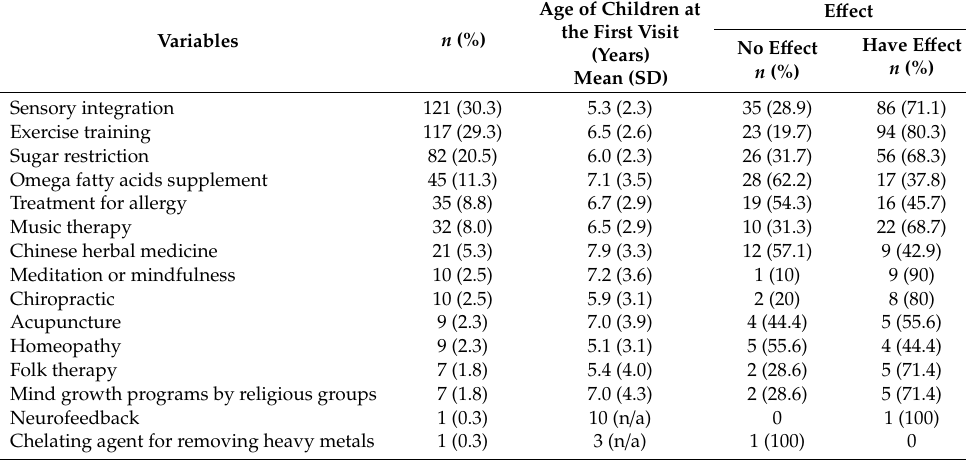
Table 2. CAIS employed by the caregivers for children’s ADHD (N = 400).